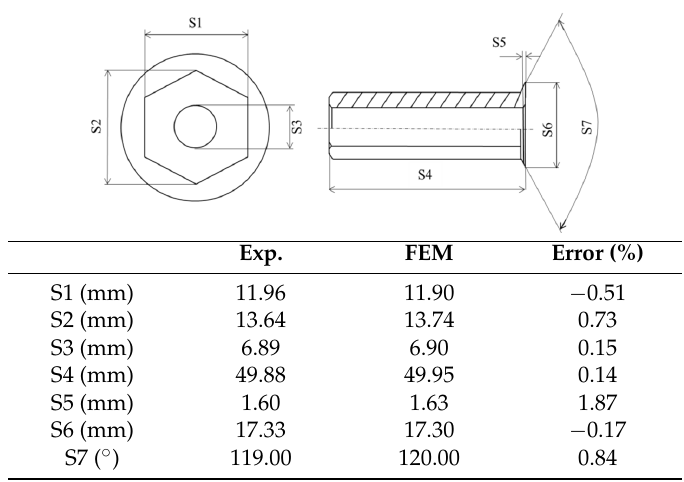
Figure 19. Workpieces of the simulation and actual long hex flange nuts from the original billet and the first to sixth stages. Table 7. Comparison of dimensions between simulation and experimental products.